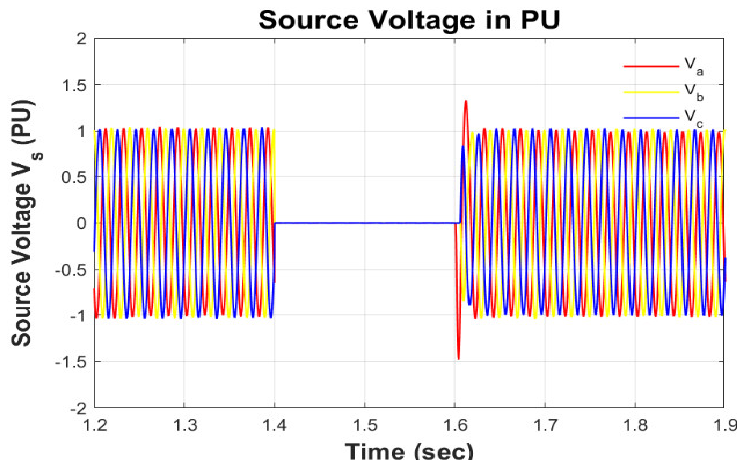
Figure 23. Source behaviour between three − phase fault.